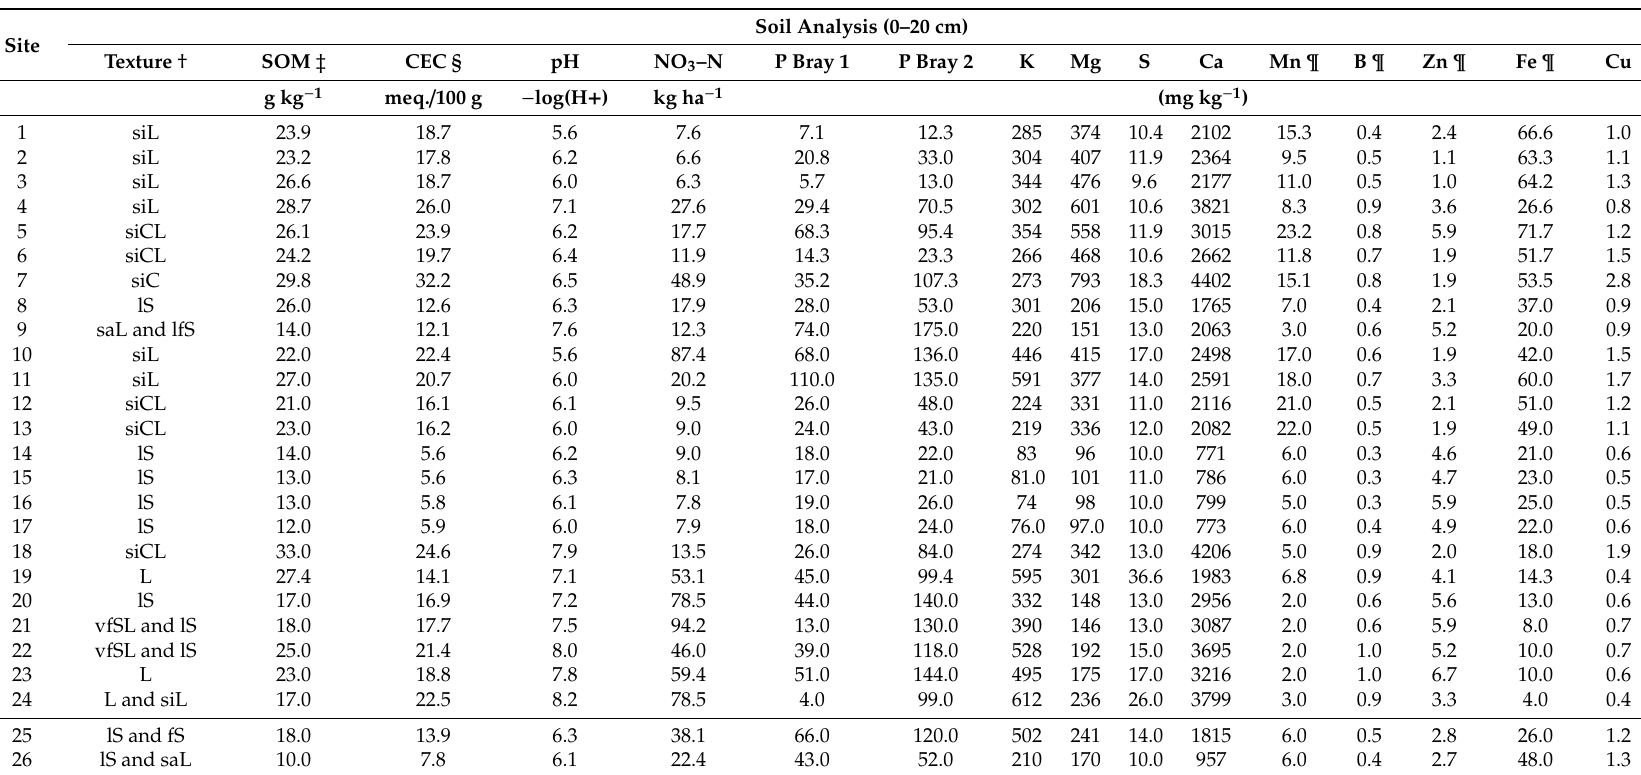
Table 3. Soil properties for the 0–20 cm depth at study sites for determining the e ff ects of foliar micronutrient application on maize. No soil micronutrient availability level was below the critical level for deficiency ¶